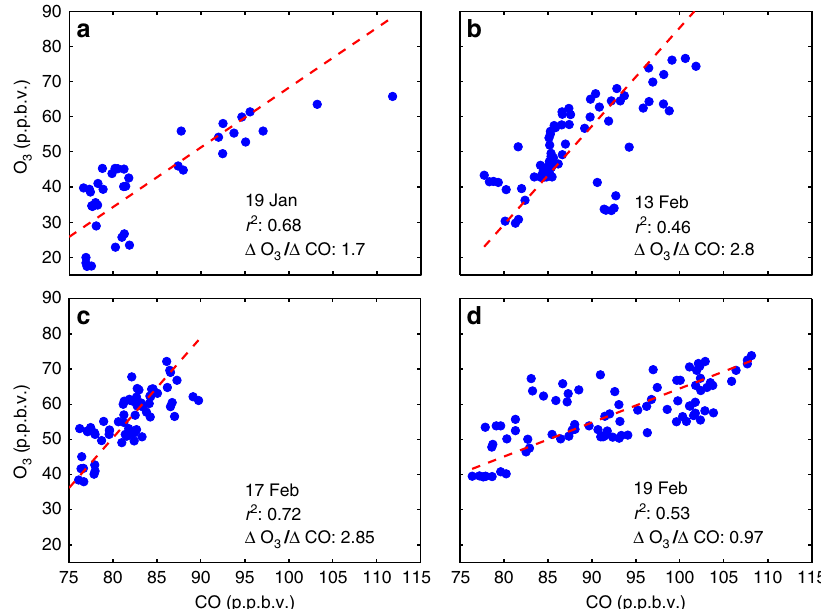
Figure 5 | Enhancement ratios of CO and ozone from CAST and CONTRAST. Regression of CO against O 3 for the data shown in Fig. 2 for pressures between 300 and 700hPa ( a – d ). The D O 3 / D CO ratio for all profiles suggests significantly aged air, consistent with the back trajectory and photochemical aging analyses. The dashed red line is the best fit via orthogonal linear regression. Flight dates, slope and r 2 values are shown for all